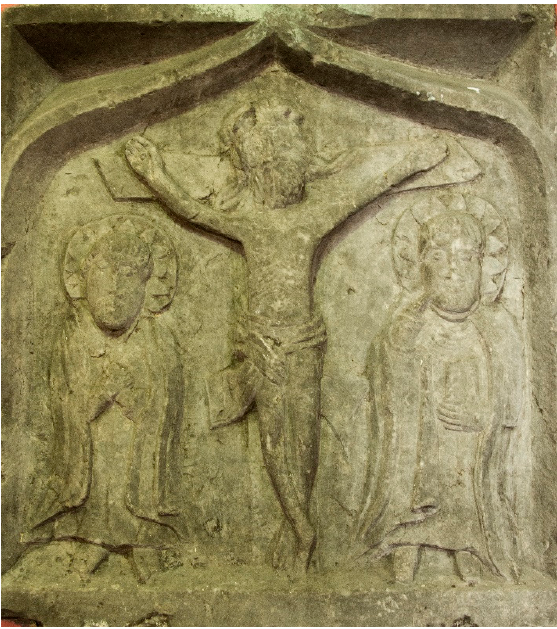
Figure 26. Tomb chest, Carmelite Priory, Co. Kildare, sixteenth century. Photograph by the author.